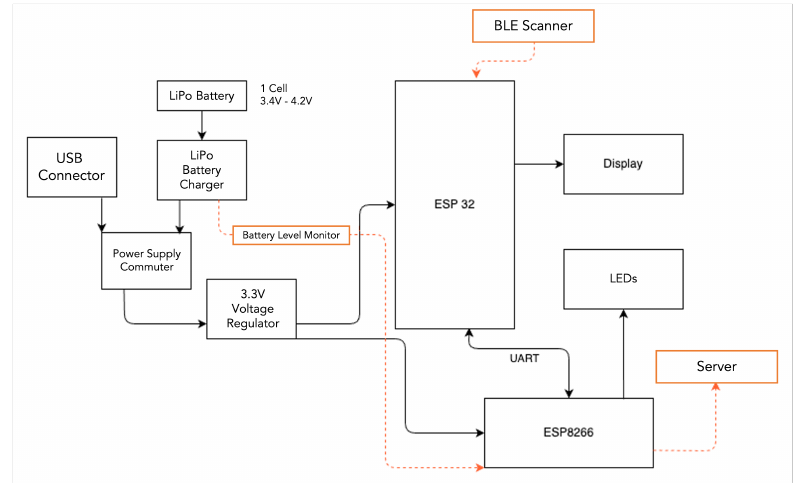
Figure 5. Block diagram of the final design of the scanning station (based on [24]).